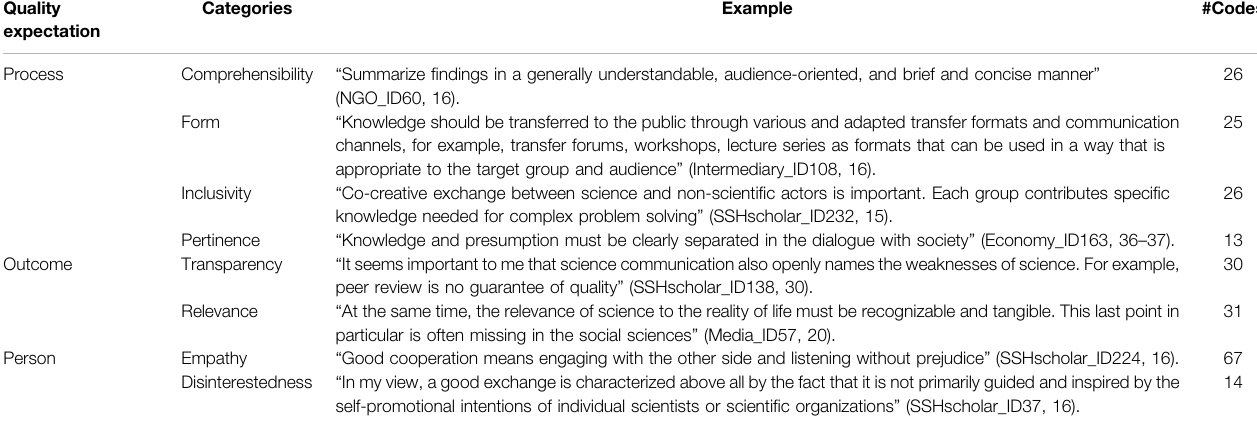
TABLE 5 | Quality